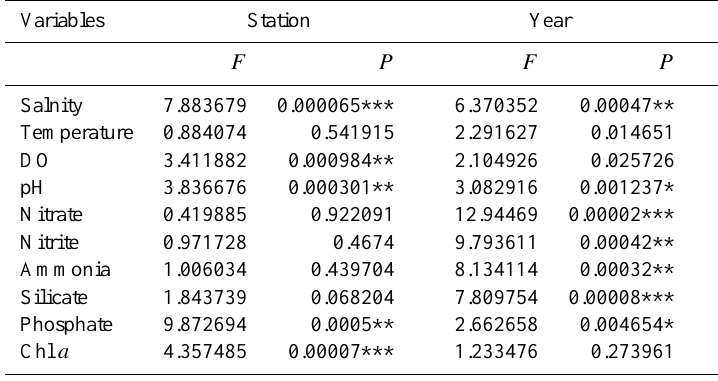
Table 2. Two-way analysis of variance for differences of ecologically important parameters on sampling stations and sampling months for the survey (June 2008 to May 2009). F indicates the likelihood ratio; P indicates the